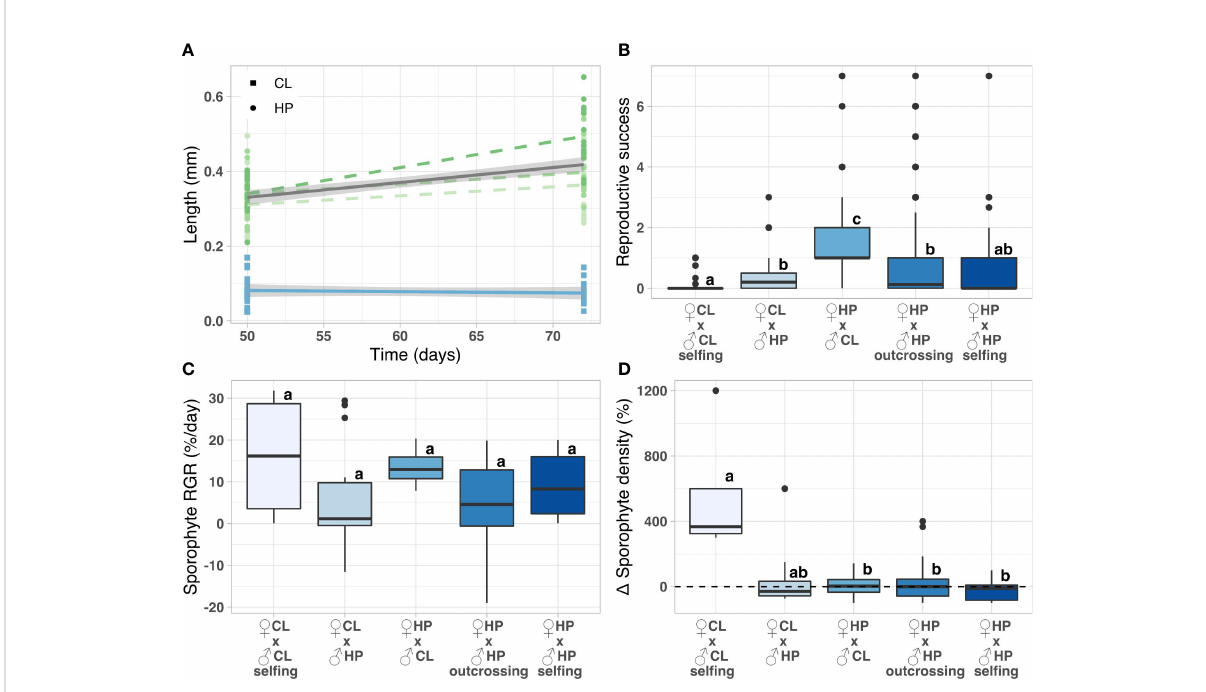
FIGURE 8 (A) Linear regression of gametophyte length measured 7 and 10 weeks after spore release for the haplodiplontic (HP) and clonal morph (CL). (B – D) Sporophyte measurements for the crossing experiment. (B) reproductive success (number of sporophytes per total number of female gametophytes), (C) sporophyte relative growth rate (RGR), (D) percentage sporophyte density change (t2 relative to t1). All measurements were taken 3 (t1) or 4 (t2) weeks after the start of the experiment. Lowercase letters indicate signi fi cant differences among sampling populations (pairwise Wilcoxon rank sum test, p < 0.05). CL and HP stand for clonal and haplodiplontic